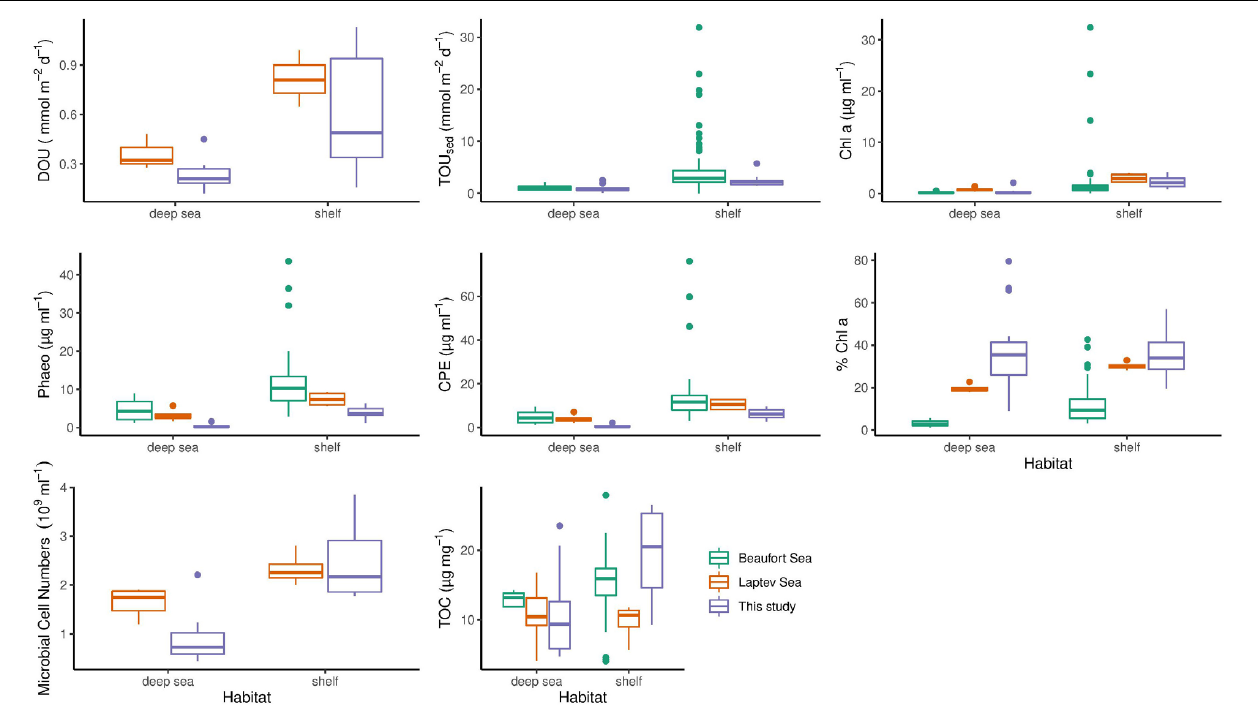
FIGURE 5 | Comparison of benthic oxygen uptake and environmental parameters across the regions of this study (purple boxes), the Laptev (orange boxes) and Beaufort Sea (green boxes). Differences between shelf and deep-sea habitats are shown. The bottom and top of the box refer to the 25th and 75th percentile, respectively. The centreline constitutes the median and the upper and lower whiskers are calculated as the upper and lower boundary of the box + 1.5 * the interquartile range. Data points outside this range are plotted as outliers. TOU sed , Total oxygen uptake; DOU, Diffusive oxygen uptake; CPE, Chloroplastic pigment equivalent; TOC, Sediment total organic carbon content; Chl a , Sediment chlorophyll a concentration; Phaeo, Sediment phaeopigment concentration.